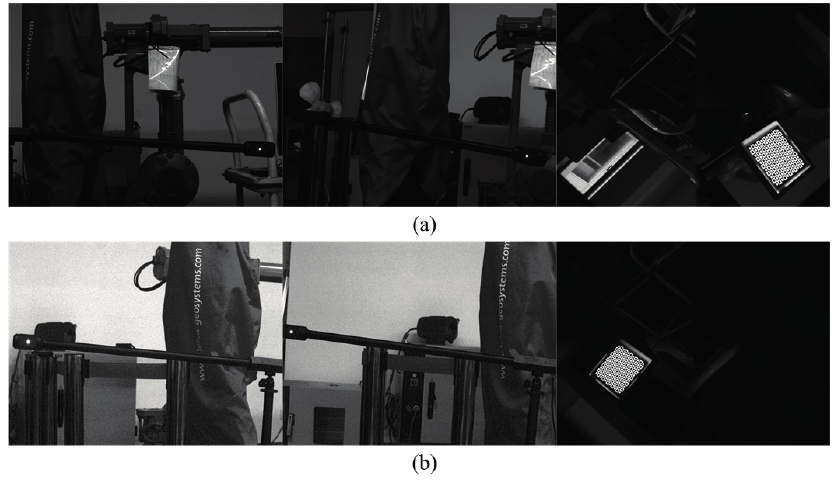
Figure 10. Images captured by two sensors for global precision